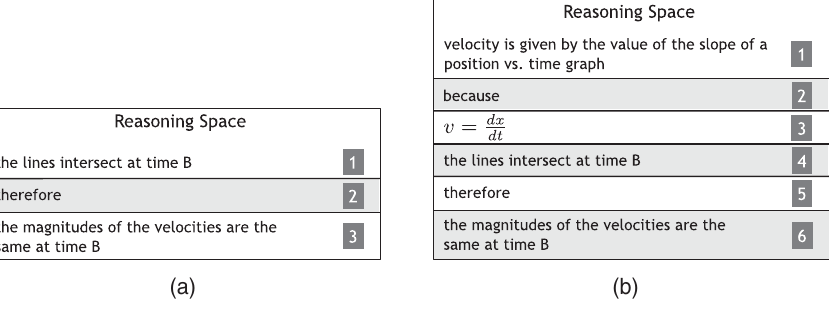
FIG. 6. (a) A canonical incorrect response in which a student solely justified the answer on the basis of the observation that the lines intersect at time B. (b) A response in which a student endorses information more closely associated with the correct line of reasoning in the process of justifying the common incorrect